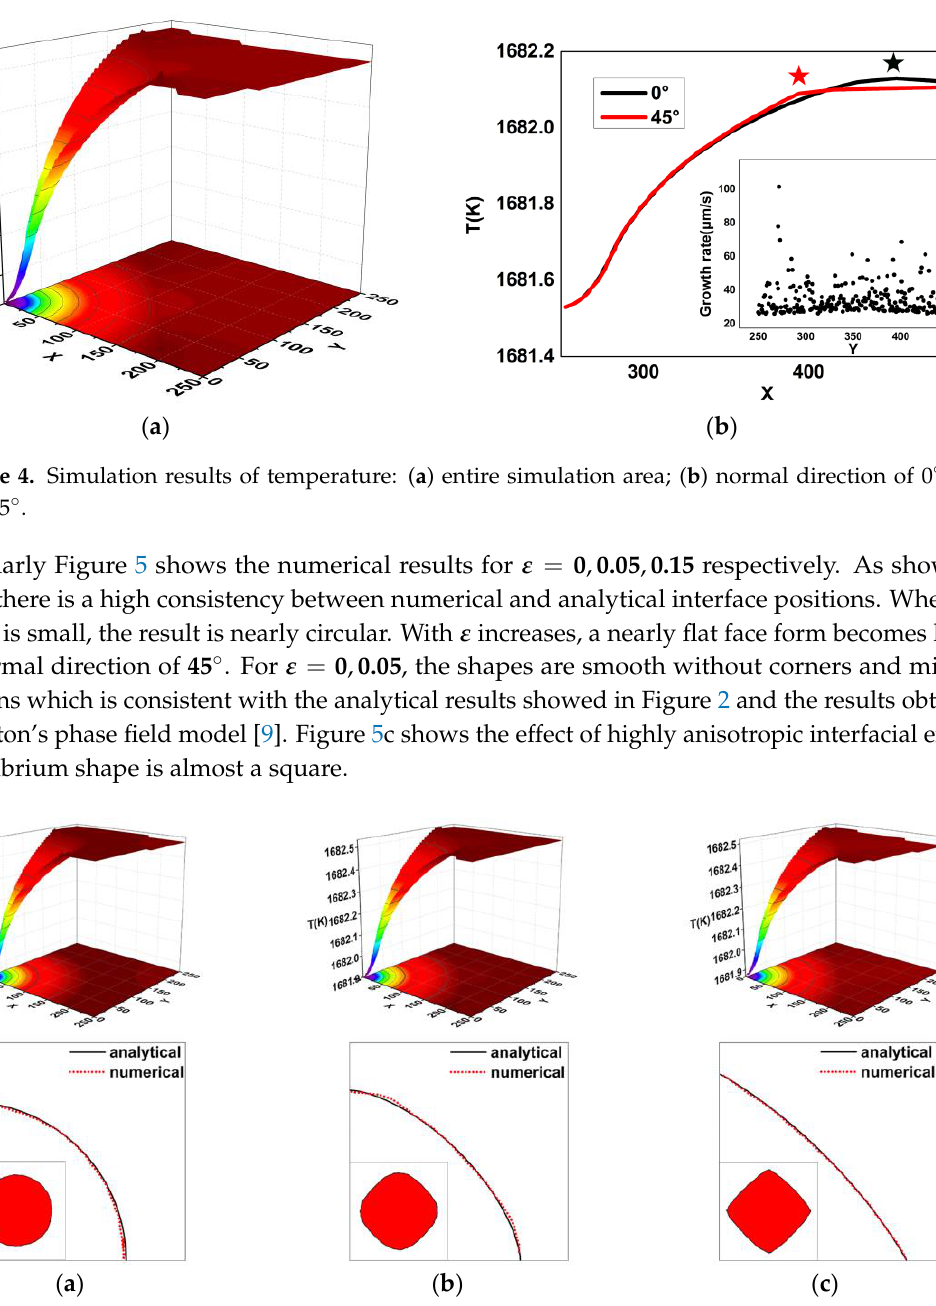
Figure 5. Simulation results for equilibrium shapes with different values of ε and the comparison of